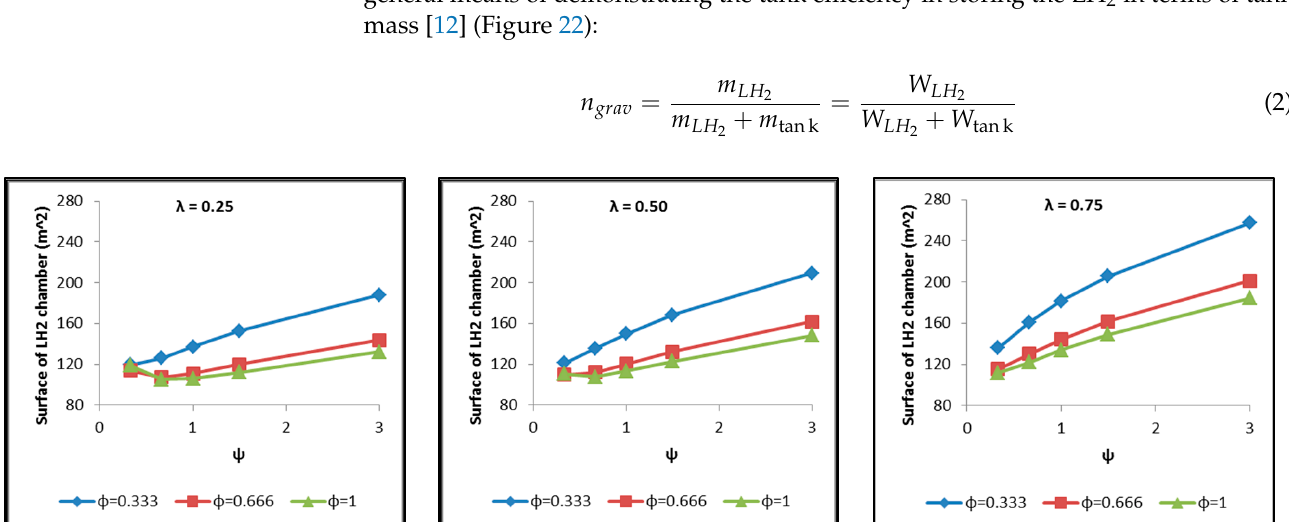
Figure 17. Distribution of the inner aluminum shell surface as a function of the ratios λ , φ and ψ .